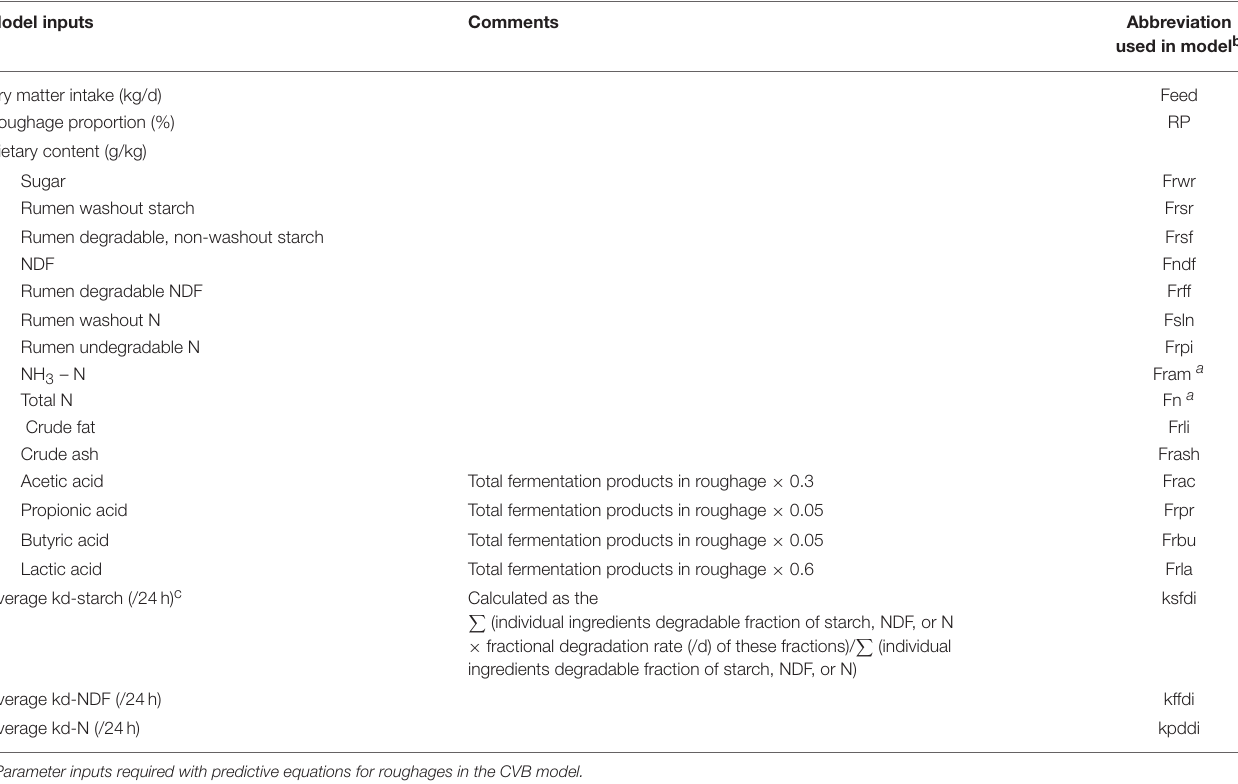
TABLE 3 | Model inputs required for prediction of apparent fecal N digestibility with the Dutch Tier 3 model (and some for the CVB model a ). Model inputs